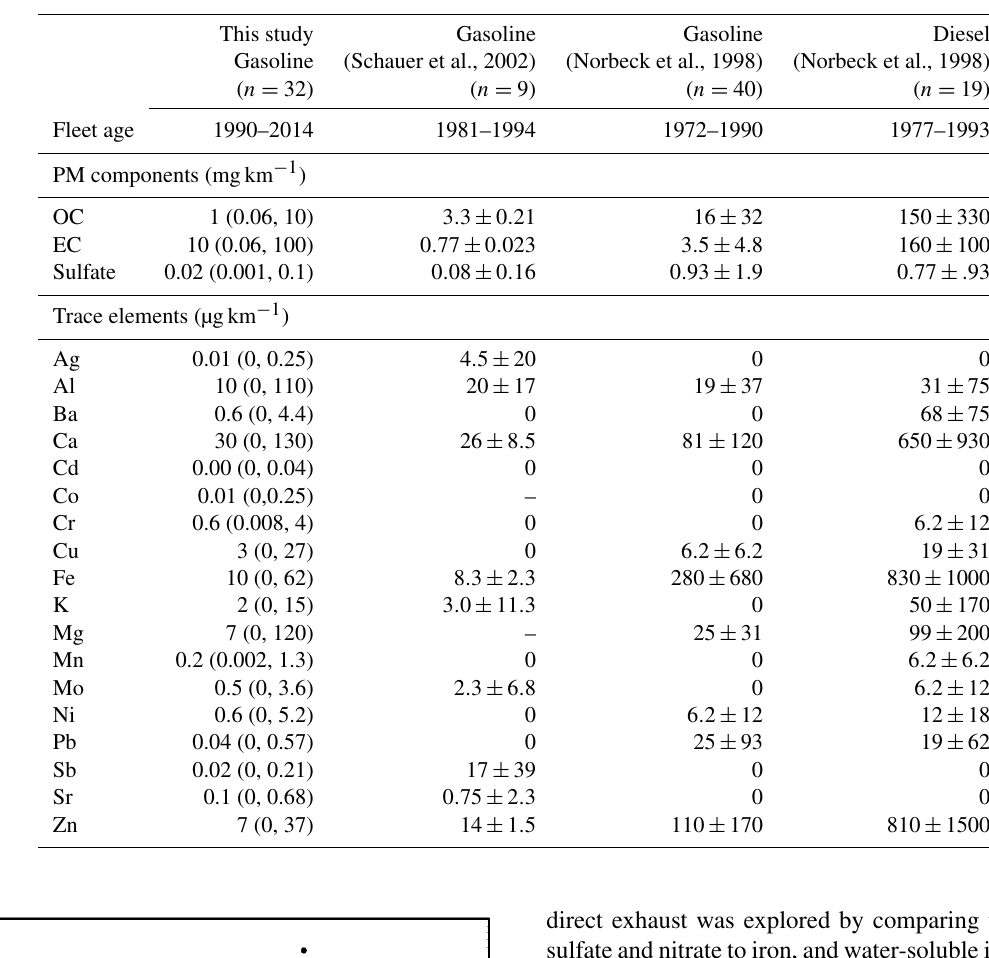
Table 2. Comparison of exhaust composition (gkm − 1 ) from different dynamometer studies that included both gasoline- and diesel-powered light-duty vehicles. The values are the mean of the vehicle population, and the values in parentheses are the minimum and maximum values. This table is in grams per kilogram as opposed to grams per kilogram of fuel in Table 1.